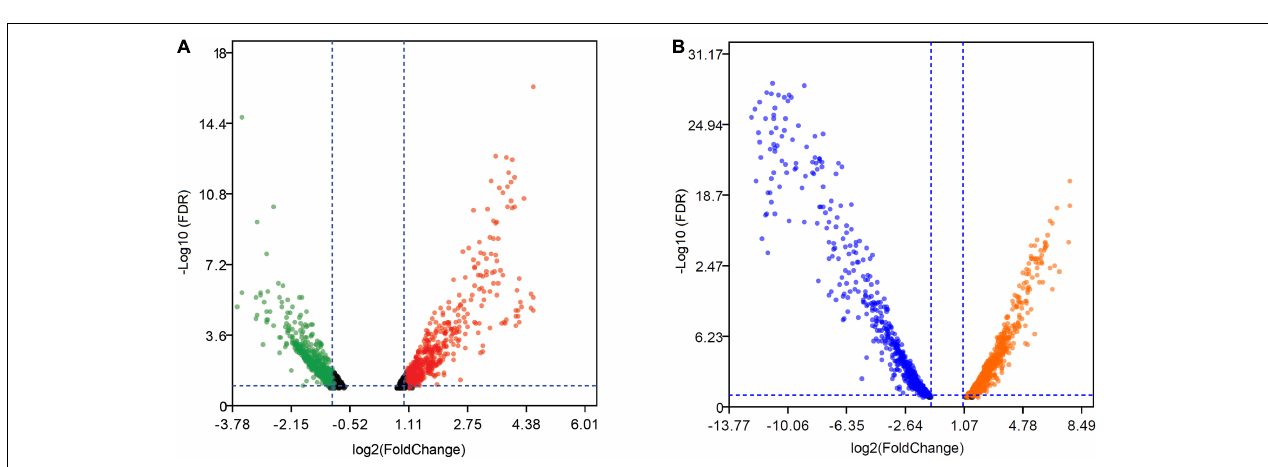
FIGURE 5 | Volcano plots of DEGs in strain ST7 under manganese stress. (A) DEGs in mid-exponential growth phase. (B) DEGs in the onset of stationary growth phase. Green and blue dots represent the downregulated genes, while red and orange dots represent the upregulated